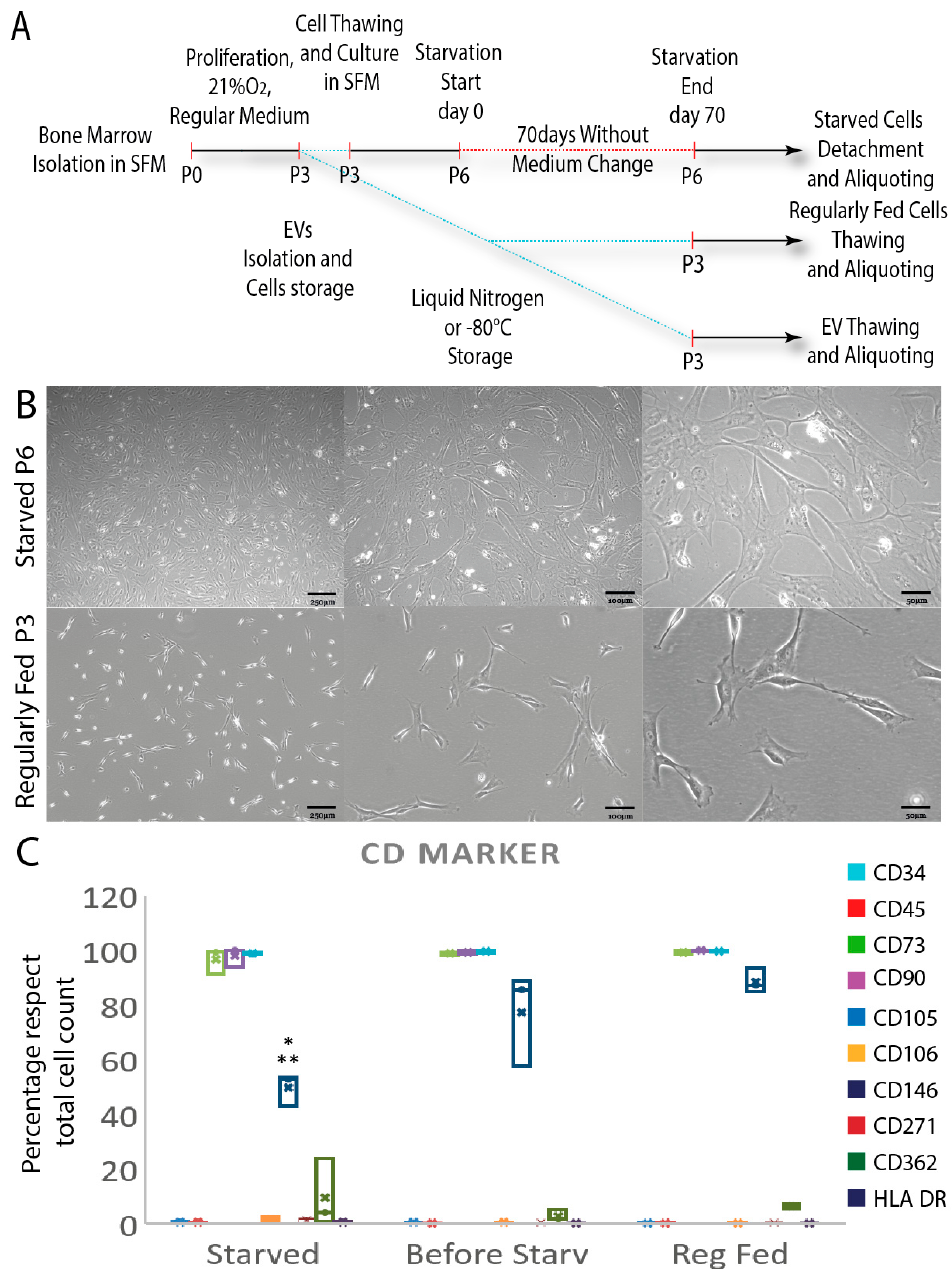
Figure 1. Starved hBM-MSC changed morphologically but retained their phenotype. ( A ) Diagram depicting the in vitro starving procedure and time-points observed throughout the investigation. ( B ) Progressive phase contrast images of 70-day-starved hBM-MSC show fibroblast-like cells with a uniform appearance with minimal differences between P6 starving cells and P3 regularly fed